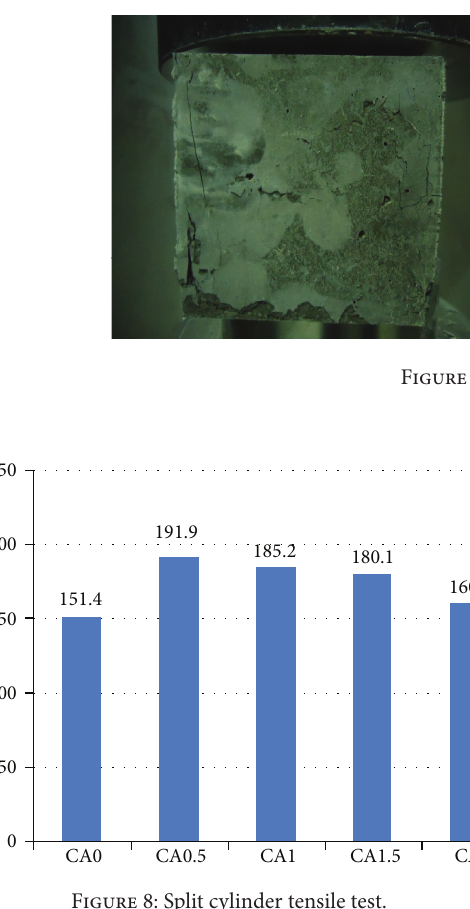
Figure 8: Split cylinder tensile test.